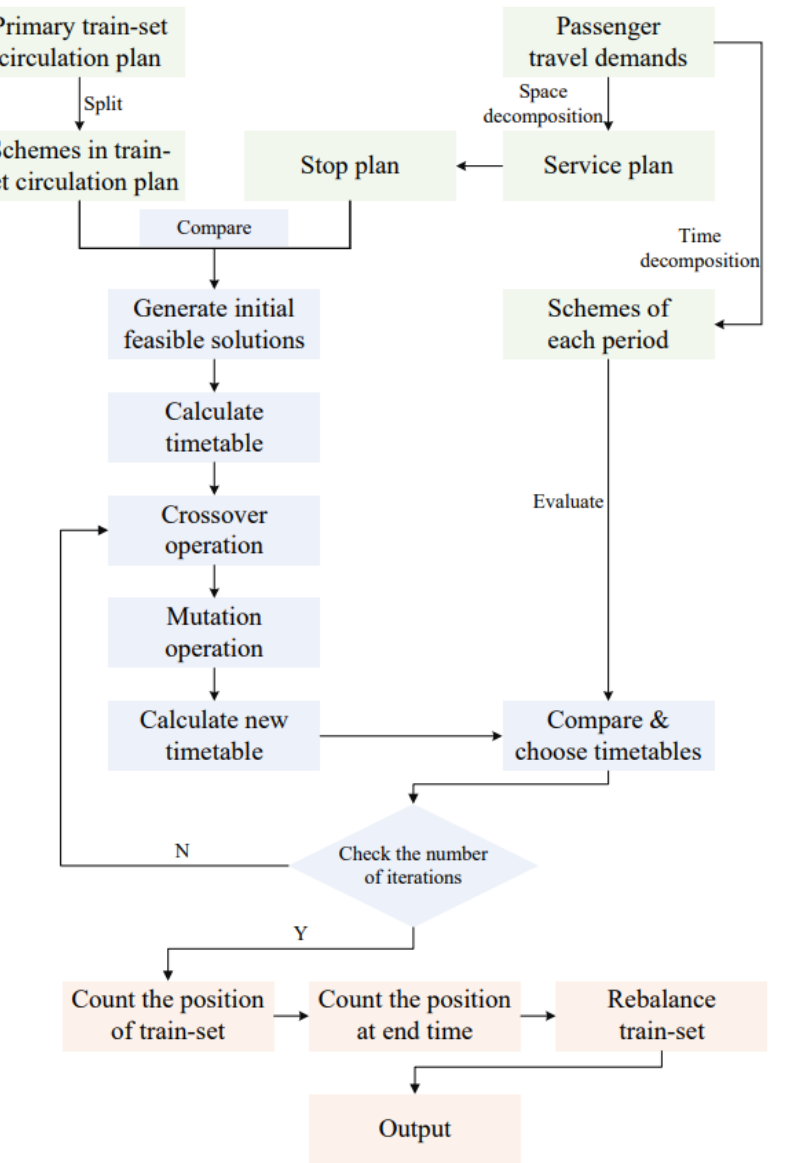
Figure 9 . The flow chart of the timetable calculation and adjustment method.5.1. Primary Train-set Circulation Plan Splitting and Corresponding Relationship .